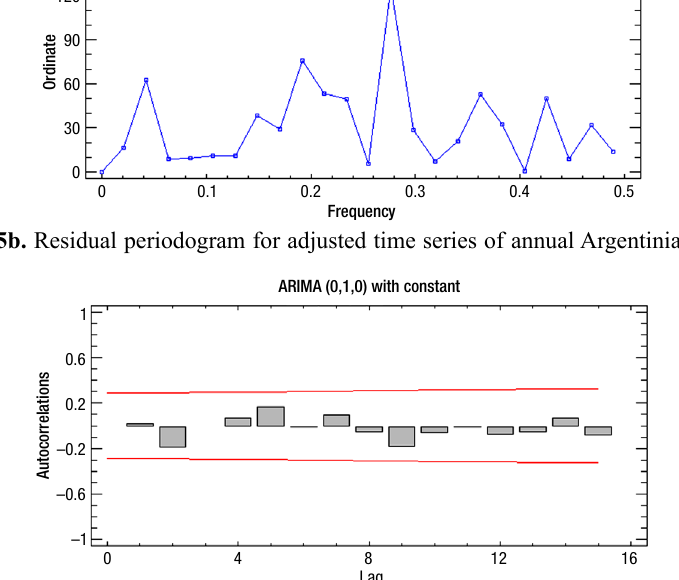
Fig. 16a. Residual autocorrelations for adjusted time series of annual Argentinian GDP